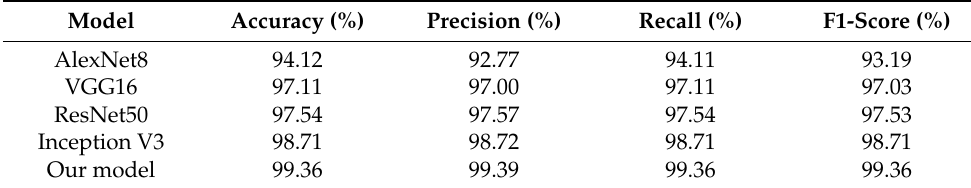
Table 6. Performance of each model.